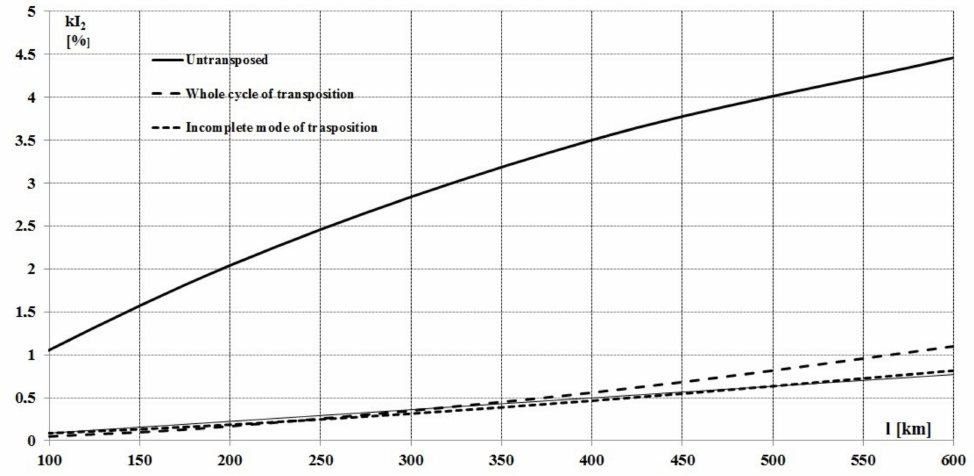
Figure 1. Dependence of the unbalance level on the line